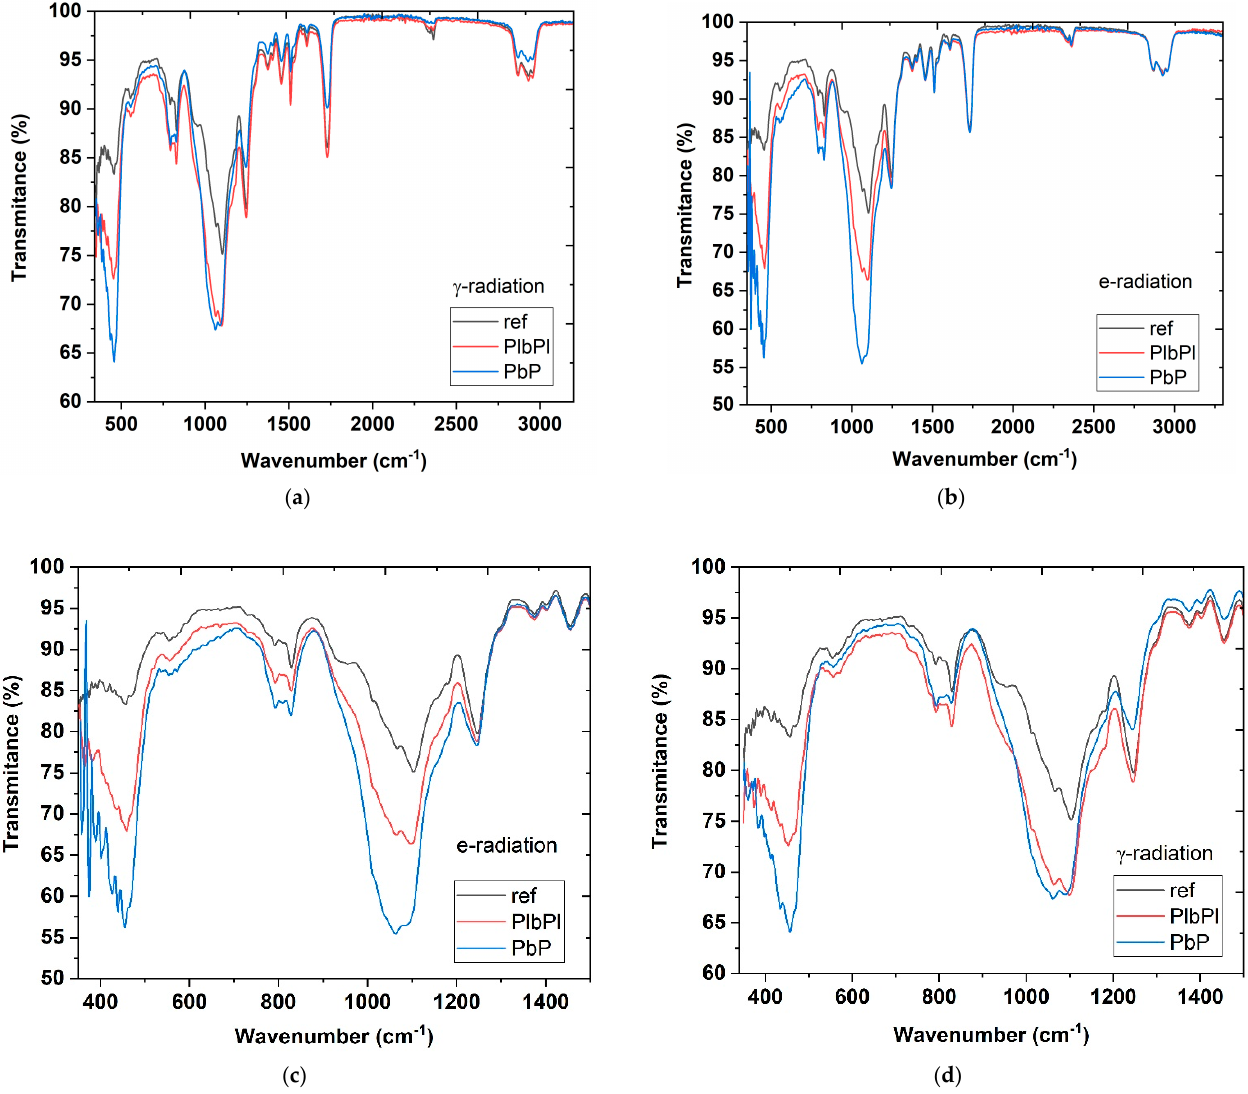
Figure 8. FTIR spectra of the irradiated (and reference) PbP- and the PlbPl- FBG samples when exposed to ( a ) γ -radiation and ( b ) e-radiation. The zoomed FTIR spectra of the exposed samples to ( c ) γ -radiation and ( d ) e-radiation.